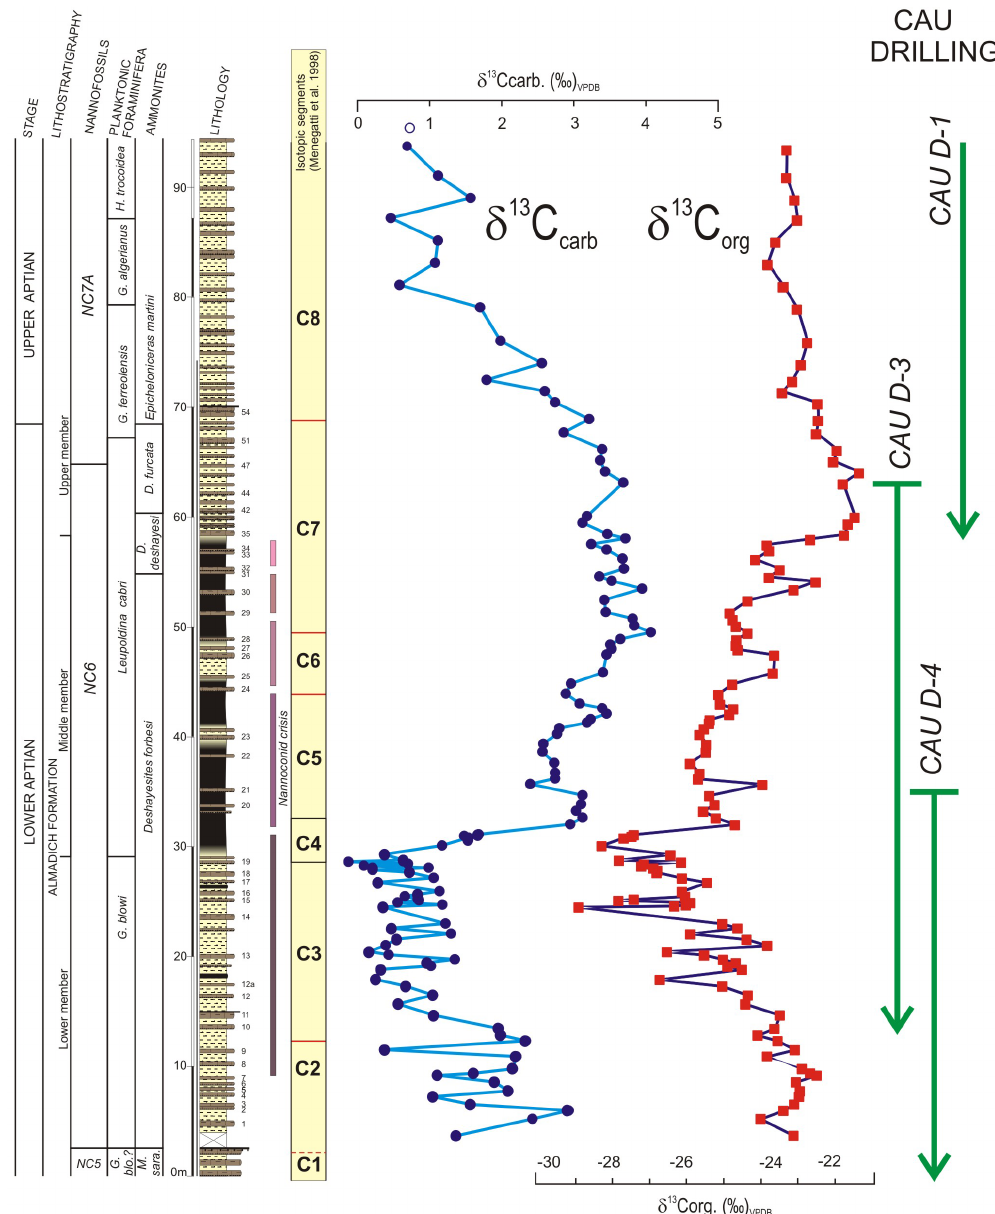
Figure 3. Stratigraphy of the Cau section: lithostratigraphy, biozones, and bioevents together with bulk carbonate (dark blue circles) and total organic matter stable carbon isotopes (red squares) (modified from Naafs et al., 2016). Isotope segments according to Menegatti et al. (1998). The parts of the succession recovered by each of the three drillings are shown to the